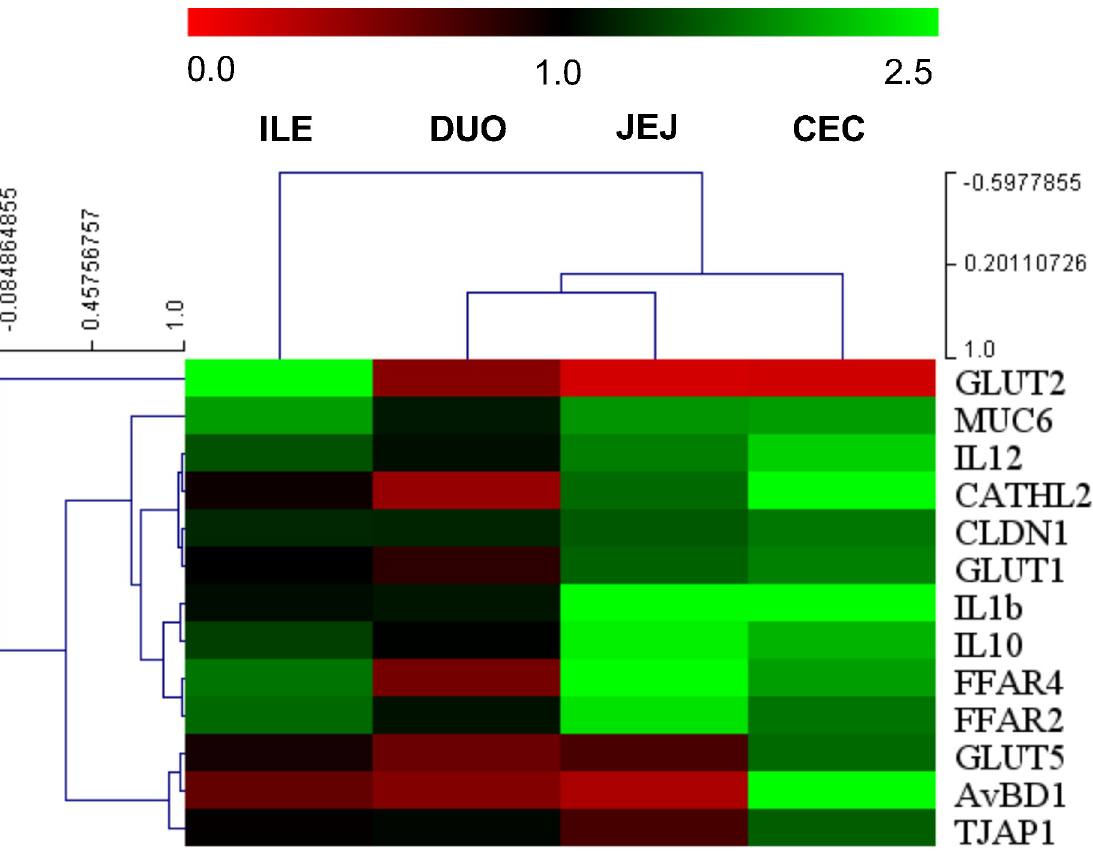
Fig 2. A heat map of hierarchically clustered gene expression in different segments of intestinal mucosa in chicken treated with GOS in ovo . Intestinal segments: DUO–duodenum, JEJ–jejunum, ILE–ileum, and CEC–caecum. In ovo injection was carried out on day 12 of egg incubation. Intestinal samples (n = 10) collected from chickens on day 42 post-hatching. RT-qPCR data were generated with custom- designed primers used for amplification with SYBR green dye; Glucose-6-phosphate dehydrogenase (G6PDH) and beta-actin (ACTB) were used as reference genes; relative gene expression (fold change) calculated as 2 – ΔΔ Ct . A Multiexperiment Viewer version 4.9 (MeV) was used for constructing a Hierarchical Cluster Tree based on fold change. Colours (red-black-green) show relative gene expression changes in GOS vs. C (red: down-regulated, green: up-regulated genes).